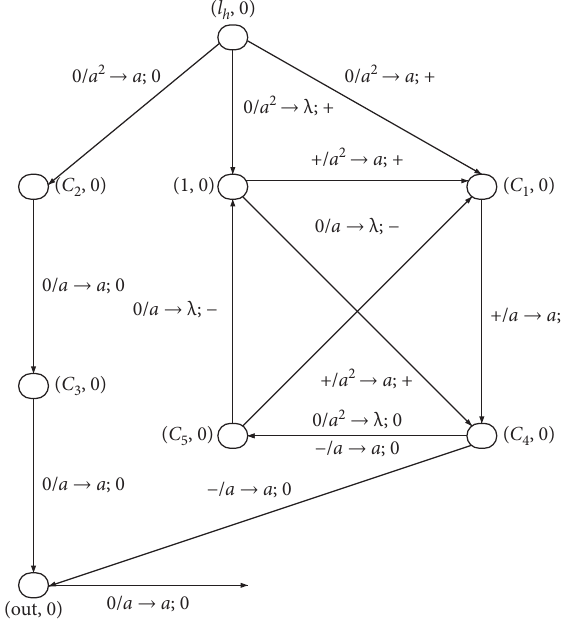
Figure 3: FIN module (ending the